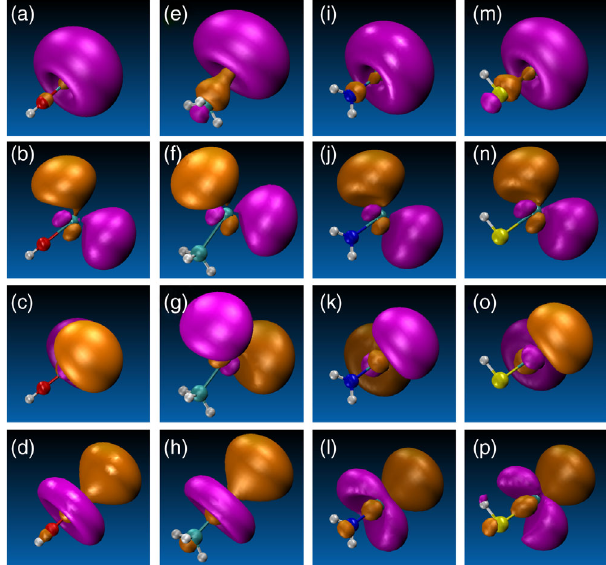
s FIG. 4. Comparison of molecular orbitals for electronic tran- sitions employed in the proposed laser cooling scheme for four ML molecules with different symmetries: CaOH [(a) – (d)], CaCH 3 [(e) – (h)], CaNH 2 [(i) – (l)], and CaSH [(m) – (p)]. Molecu- lar geometries are plotted for the ground electronic state; rows 1 – 4 correspond to SOMO, LUMO, LUMO þ 1 , and LUMO þ 2 configurations, respectively. Molecular symmetry is incremen- tally reduced from column 1 to column 4: C ∞ All isosurfaces are plotted for the isovalue of 0.03 with magenta (orange) representing positive (negative)